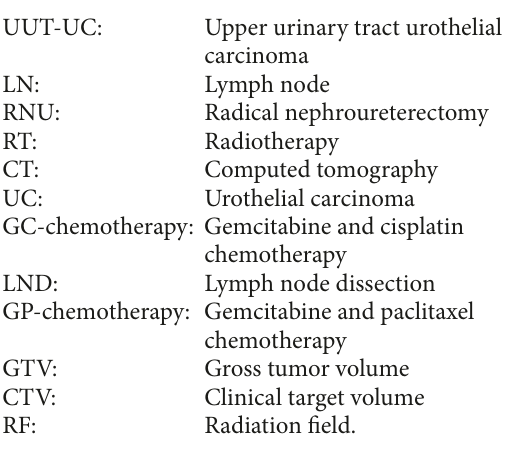
Supplementary 2. Figure S2: CT imaging of the lymph nodes . Total CT imaging of the lymph nodes: obturator, common